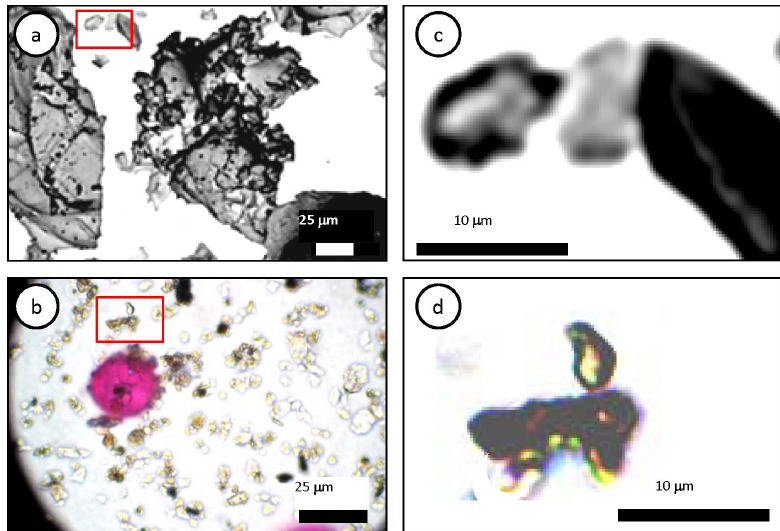
Fig. 1. (a) Scanning electron microscope pictures of the Ey1 sample showing ash particles of 100–200µm and smaller, collected ap- proximately 8km south of the active vent on 11 May 2010. (b) Photo of particles in pollen sampler (hirst-type) in Zurich, Switzerland, about 2500km from the volcano, on 19 April. Sampling efficiency in the pollen sampler decreases for particles < 5µm, vanishing below 1µm. The large pink particle is a pollen particle, the small irregular particles are mostly volcanic ash particles (photo: Barbara Pietragalla, MeteoSchweiz). Particles in the red boxes are shown on the right ( c and d ) at larger